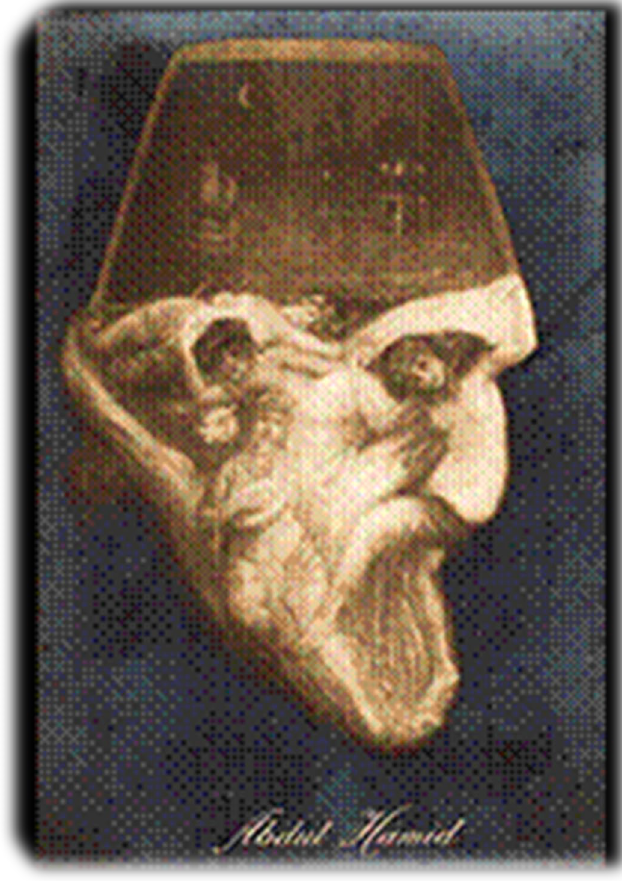
Figure 5. An old man wearing a fez.